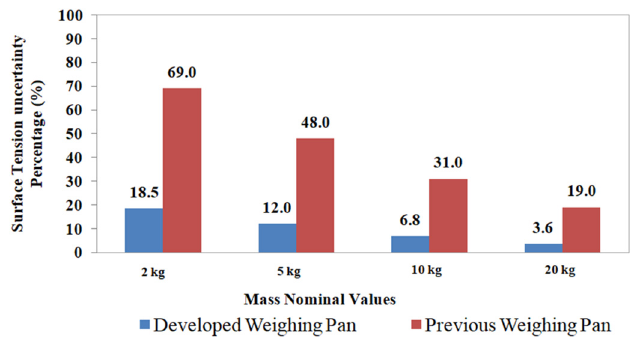
Fig. 14. The surface tension uncertainty percentage contribu- tion for the masses from 2kg up to 20 kg.